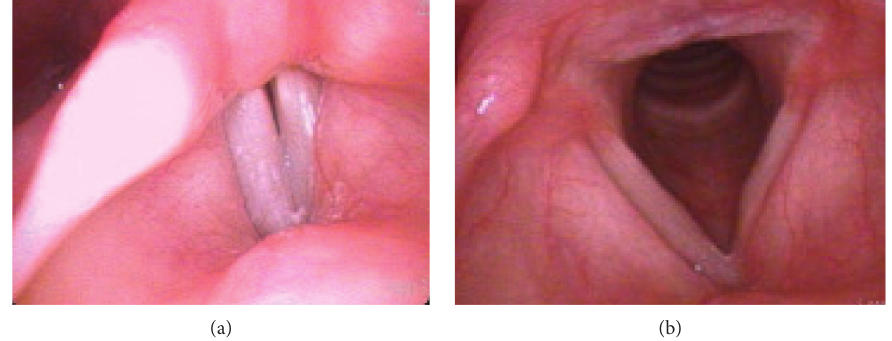
Figure 1: Laryngovideostroboscopy exam showing (a) fullness of the left false vocal fold compared to the right with mild posterior glottal gap and (b) subtle fullness of the left true vocal fold.